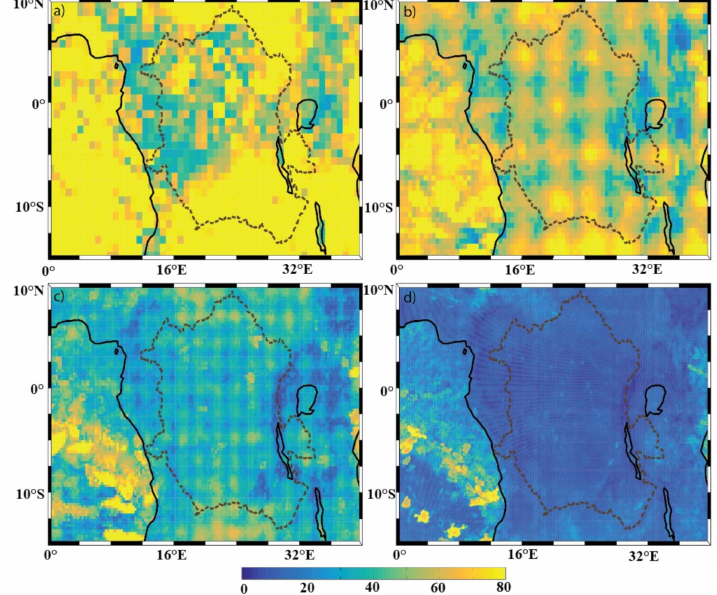
Figure 7. Spatial distribution of the precipitation decorrelation length scale (km) of the ( a ) ERA-I; ( b ) eERA5; ( c ) ERA5; and ( d ) ECOA datasets from 2016–2017. The Congo Basin is outlined with a dotted line. Panels ( a ) through ( c ) have a colormap ranging from 20–150 km, and panel ( d ) has a colormap ranging from 0–30 km. The color bar at the bottom is applicable to all